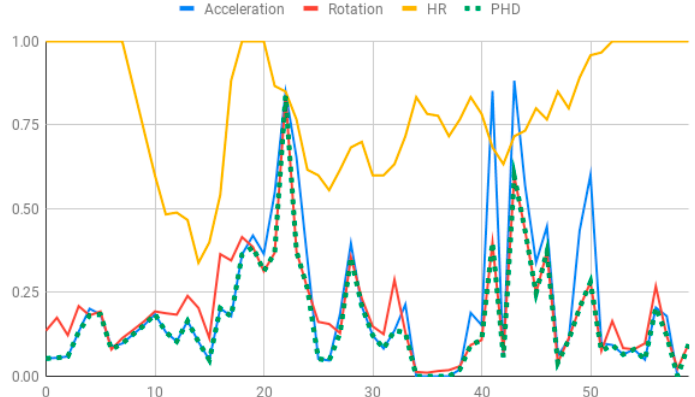
Figure 5. Membership degree to each data type to their relevant value and the membership degree to the protoform as an estimator for the hyperactive